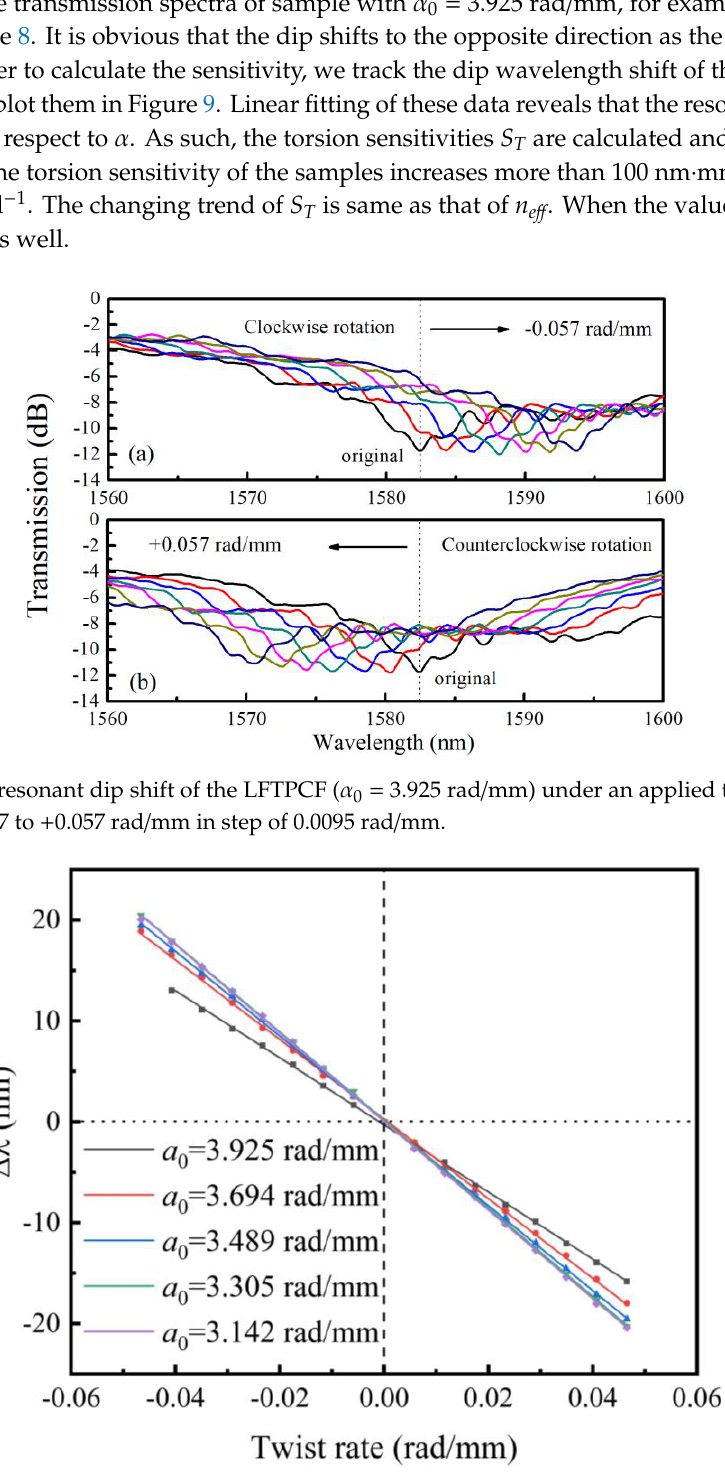
Figure 9. The linear fitting between the applied twist rate and wavelength shifts for the LFTPCFs with various α 0 .